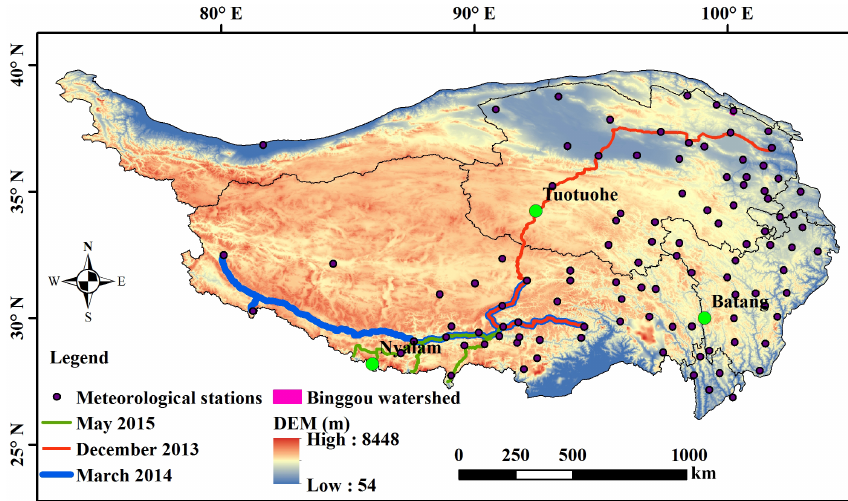
Figure 1. Distribution of meteorological stations, the location of Binggou watershed and three snow observation routes described in the text overlaid on a digital elevation model for elevation and topography of the